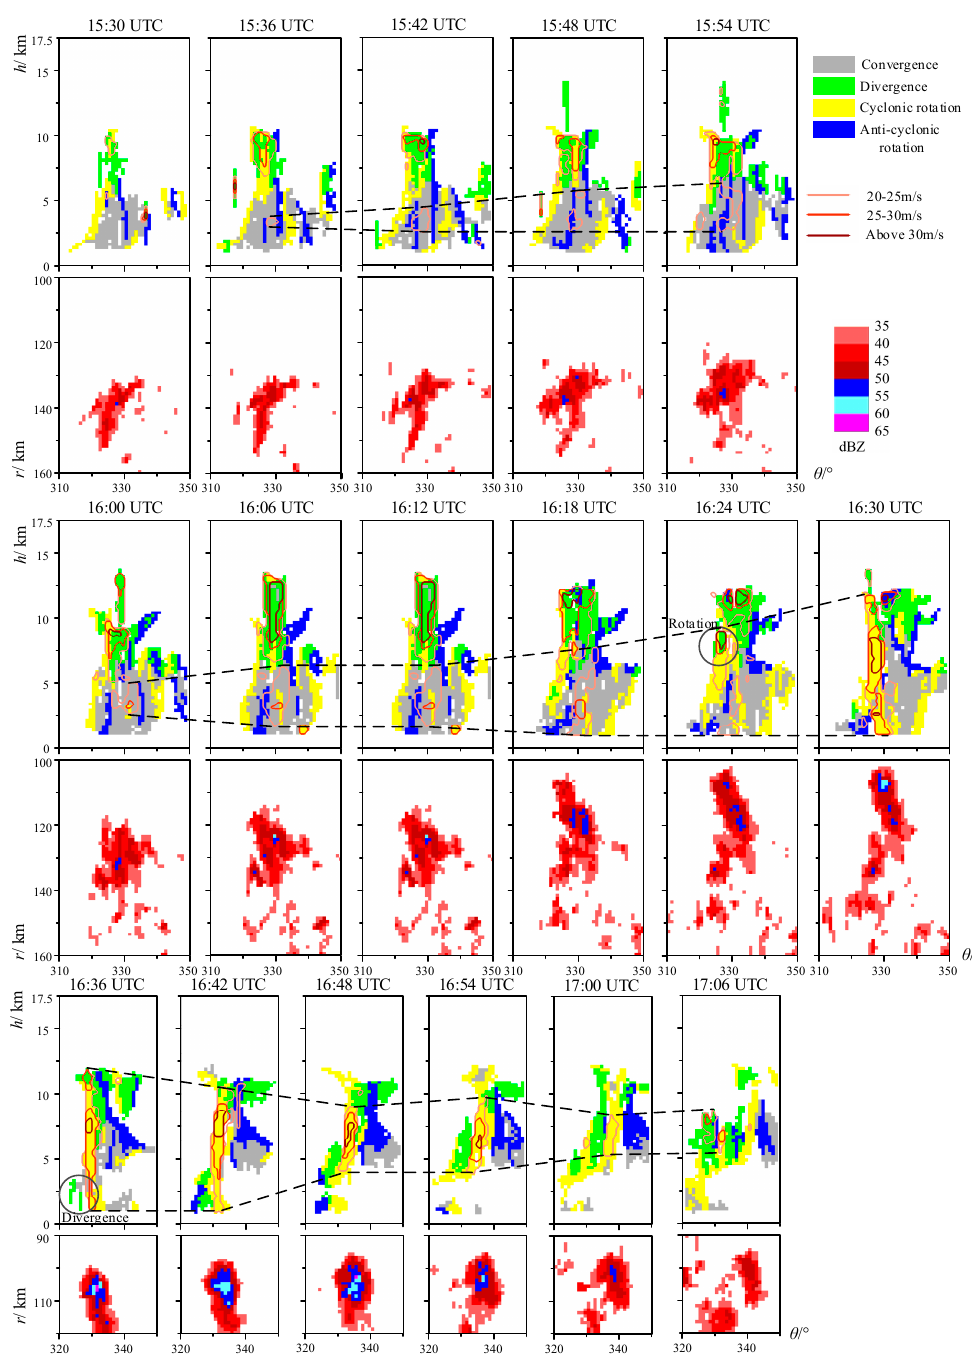
Figure 9. The PMAFSTIs and the corresponding composite reflectivity maps in the θ - r rectangular coordinate system of the event of a cell’s development and dissipation (30 July 2015). Two black dashed lines in the figure connect, respectively, the highest and lowest points of the high-intensity region in the PMAFSTIs of different moments.